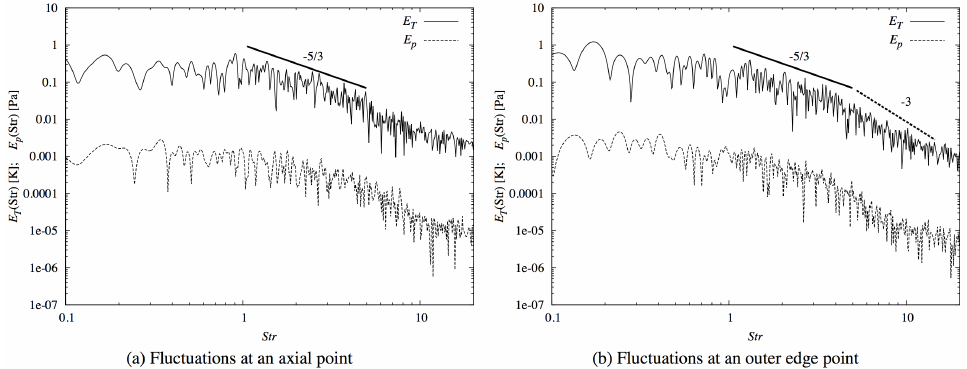
Figure 8. Temperature (solid) and pressure (dashed) fluctuations energy spectra: (a) at a point along the plume axis (0, 0, 0.5715)m; (b) at a point along the plume outer edge (0, 0.06858, 0.5715)m. The slopes Str − 5 / 3 and Str − 3 are represented with a thick solid and dashed line respectively.